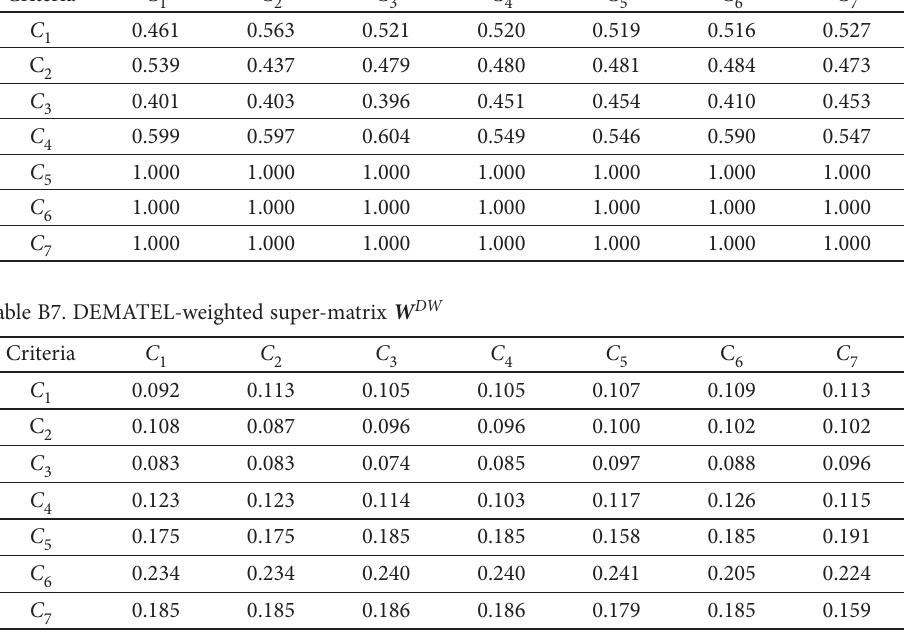
Table B6. Un-weighted super-matrix W Criteria